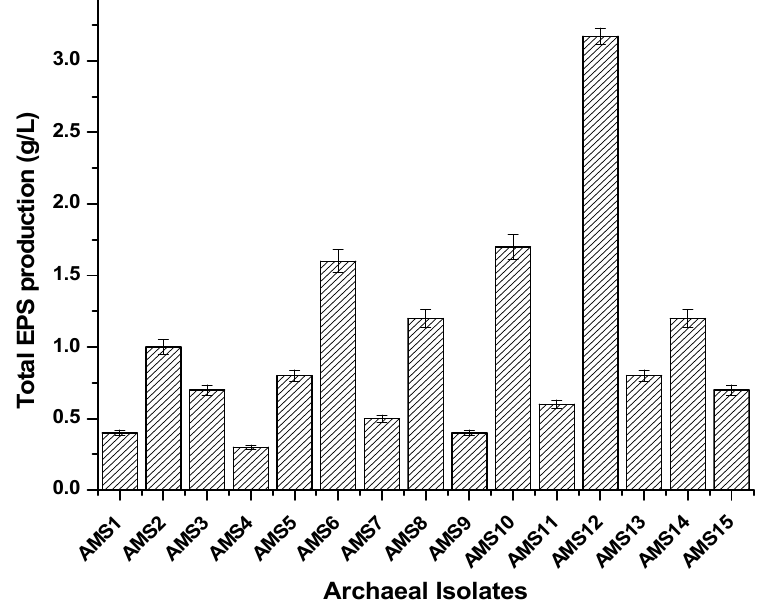
Figure 4. Total EPS production of archaeal isolates AMS12 on HAA.